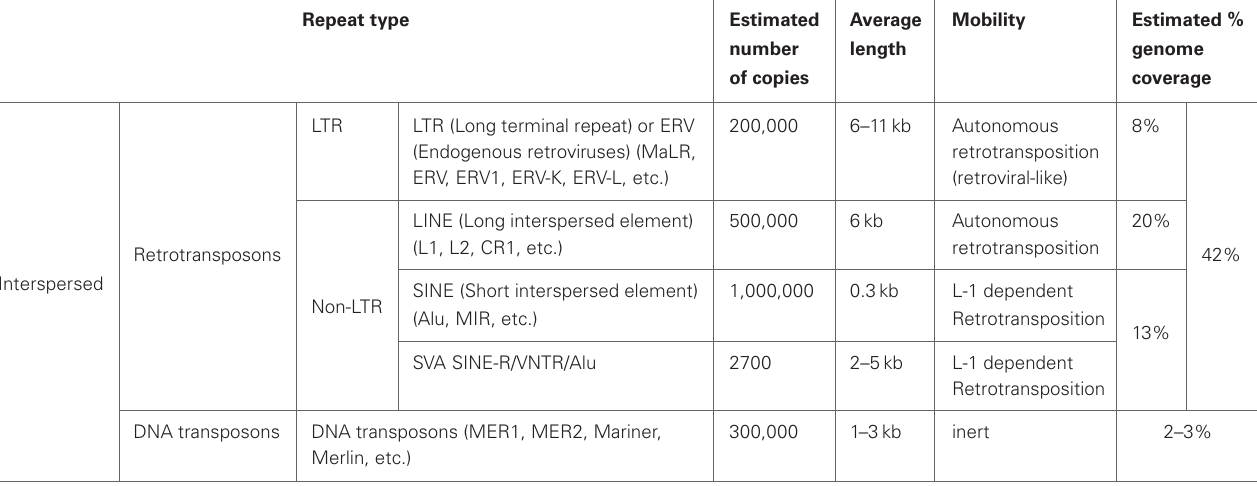
Table 1 | Major features of the most represented interspersed repetitive elements in the human